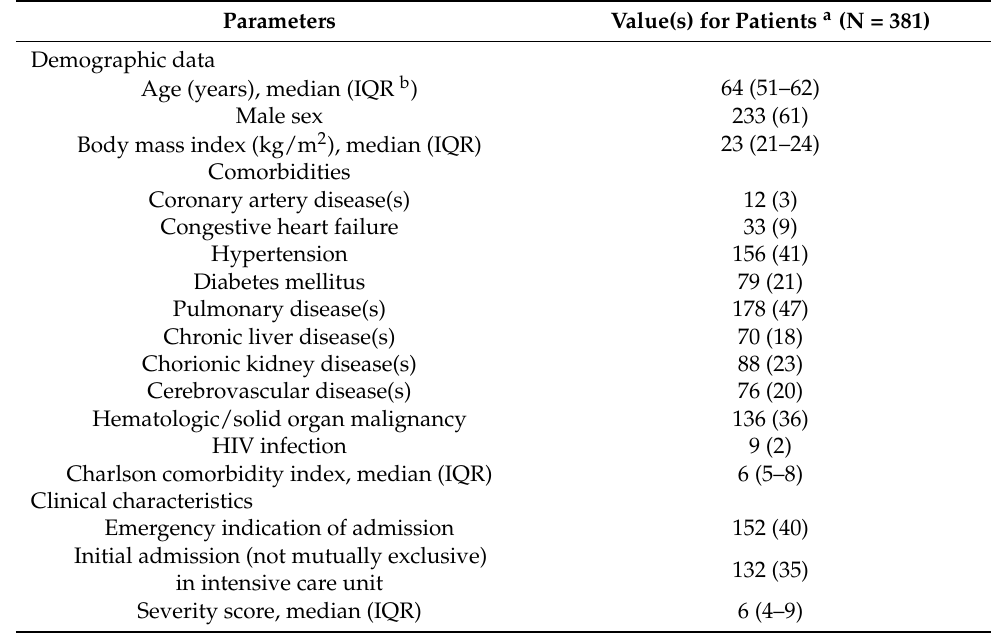
Figure 1. Patients’ enrollment criteria. Table 1. Demographic and baseline characteristics of the patients receiving intravenous